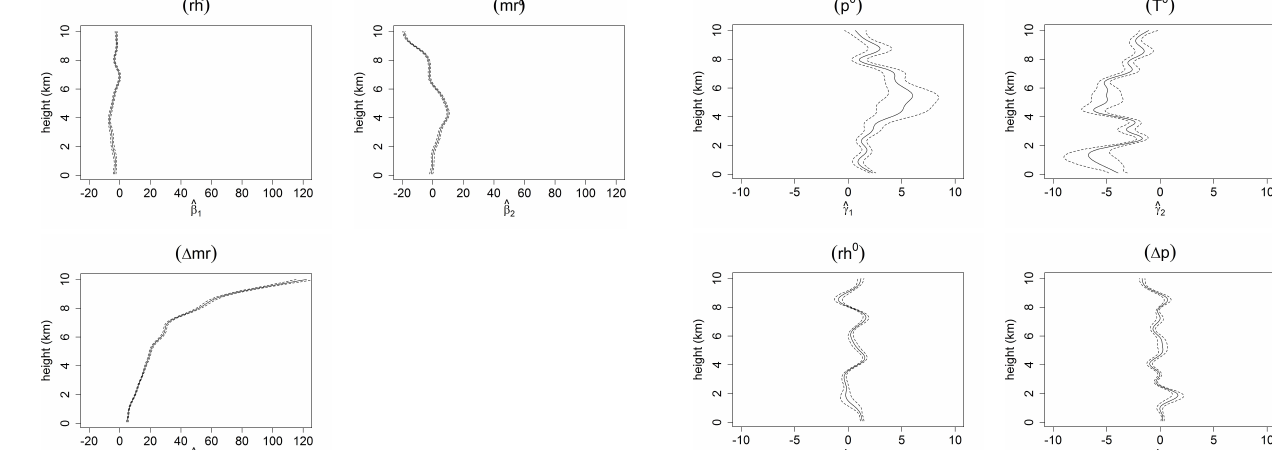
Fig. 5. Beta functions for Beltsville relative humidity ( rh ) collocation drift model (14) . Top left: Sterling relative humidity (cid:0) rh 0 (cid:1) ; top right: Sterling mixing ratio (cid:0) mr 0 (cid:1) ; bottom left: difference in mixing ratio (∆ mr ) .